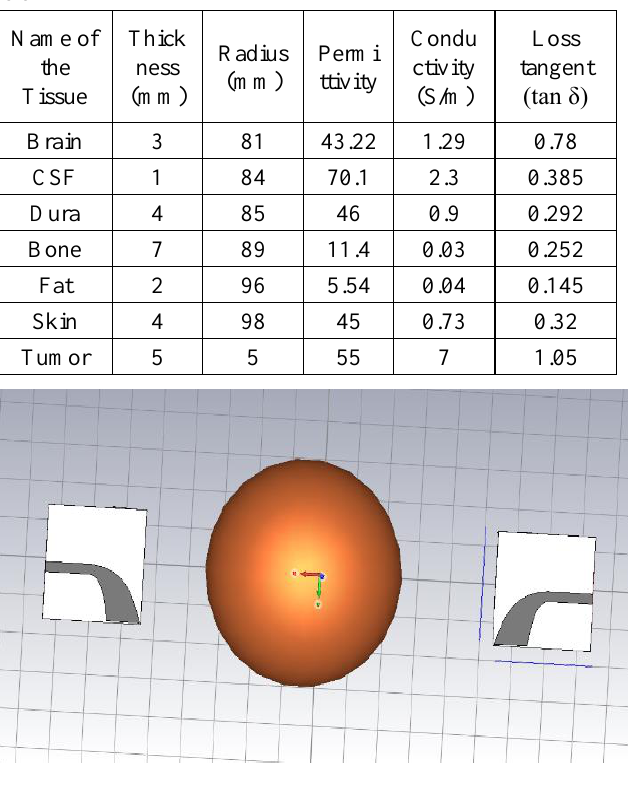
FIGURE 4. Virtual phantom in CST microwave studio